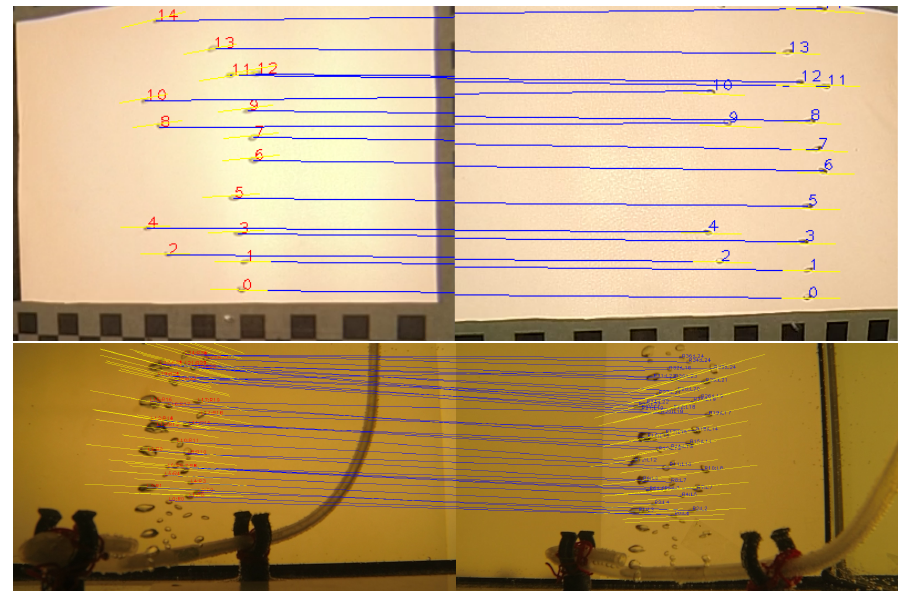
Figure 9. Exemplary results for stereo matching. Top : few bubbles, matching works very well. Bottom : many bubbles with overlap, where the matching procedure will make some errors.